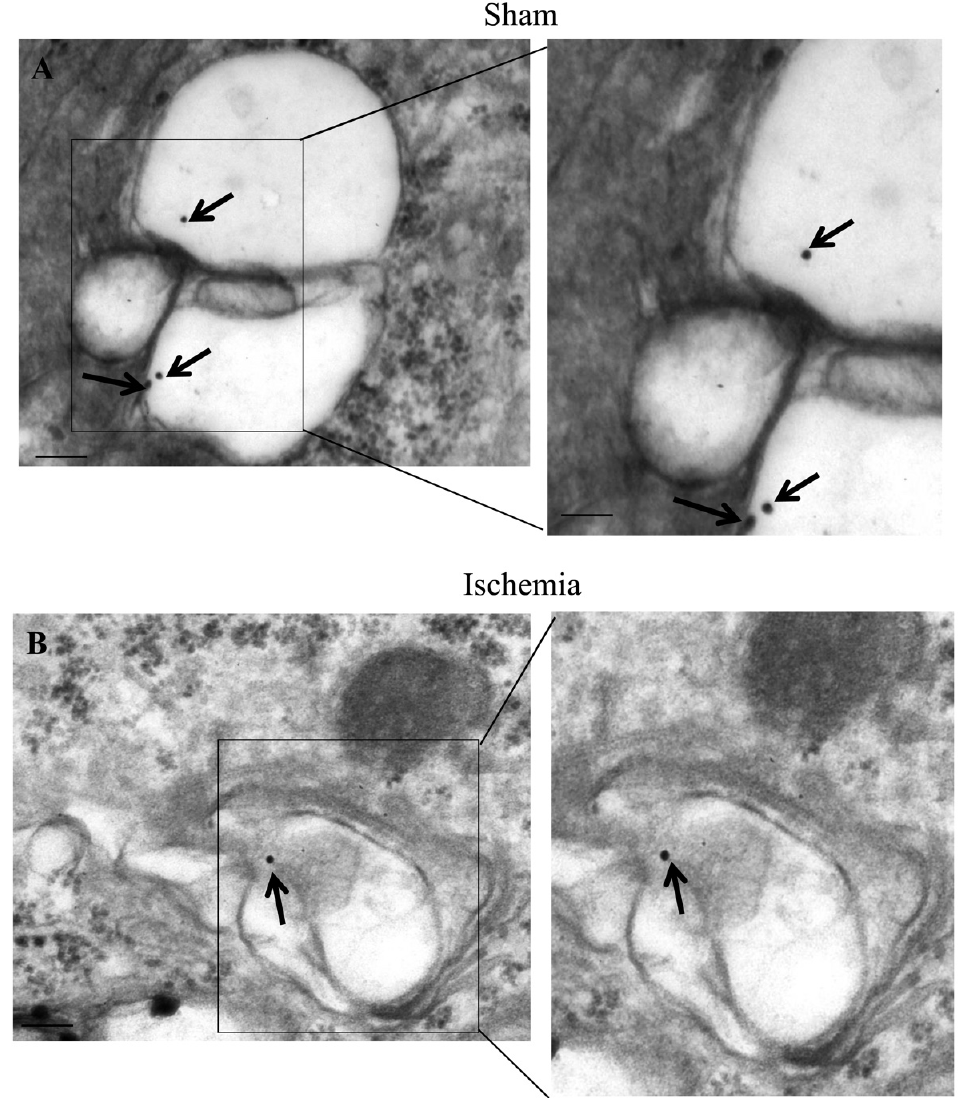
Figure 9. LC3 within area penumbra . Representative TEM micrographs showing LC3-positive vacuoles from an allo-cortical neuron from a ventral region homologous to area penumbra from a sham mouse (Sham, A ) and from an allo-cortical neuron from ventral area penumbra from an ischemic mouse (Ischemia, B ). Arrows point to LC3 immuno-gold particles (20 nm) within vacuoles. The insert highlights the immuno-gold particles within vacuoles. Scale bar = 0.2 μ m ( A , B ), 0.1 μ m (inserts).